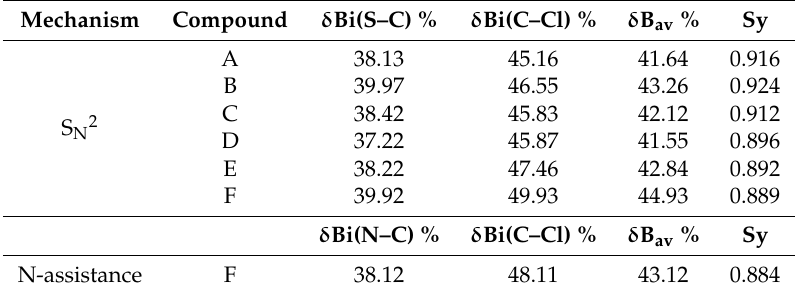
Table 5. Wiberg bond indexes changes, average value, and